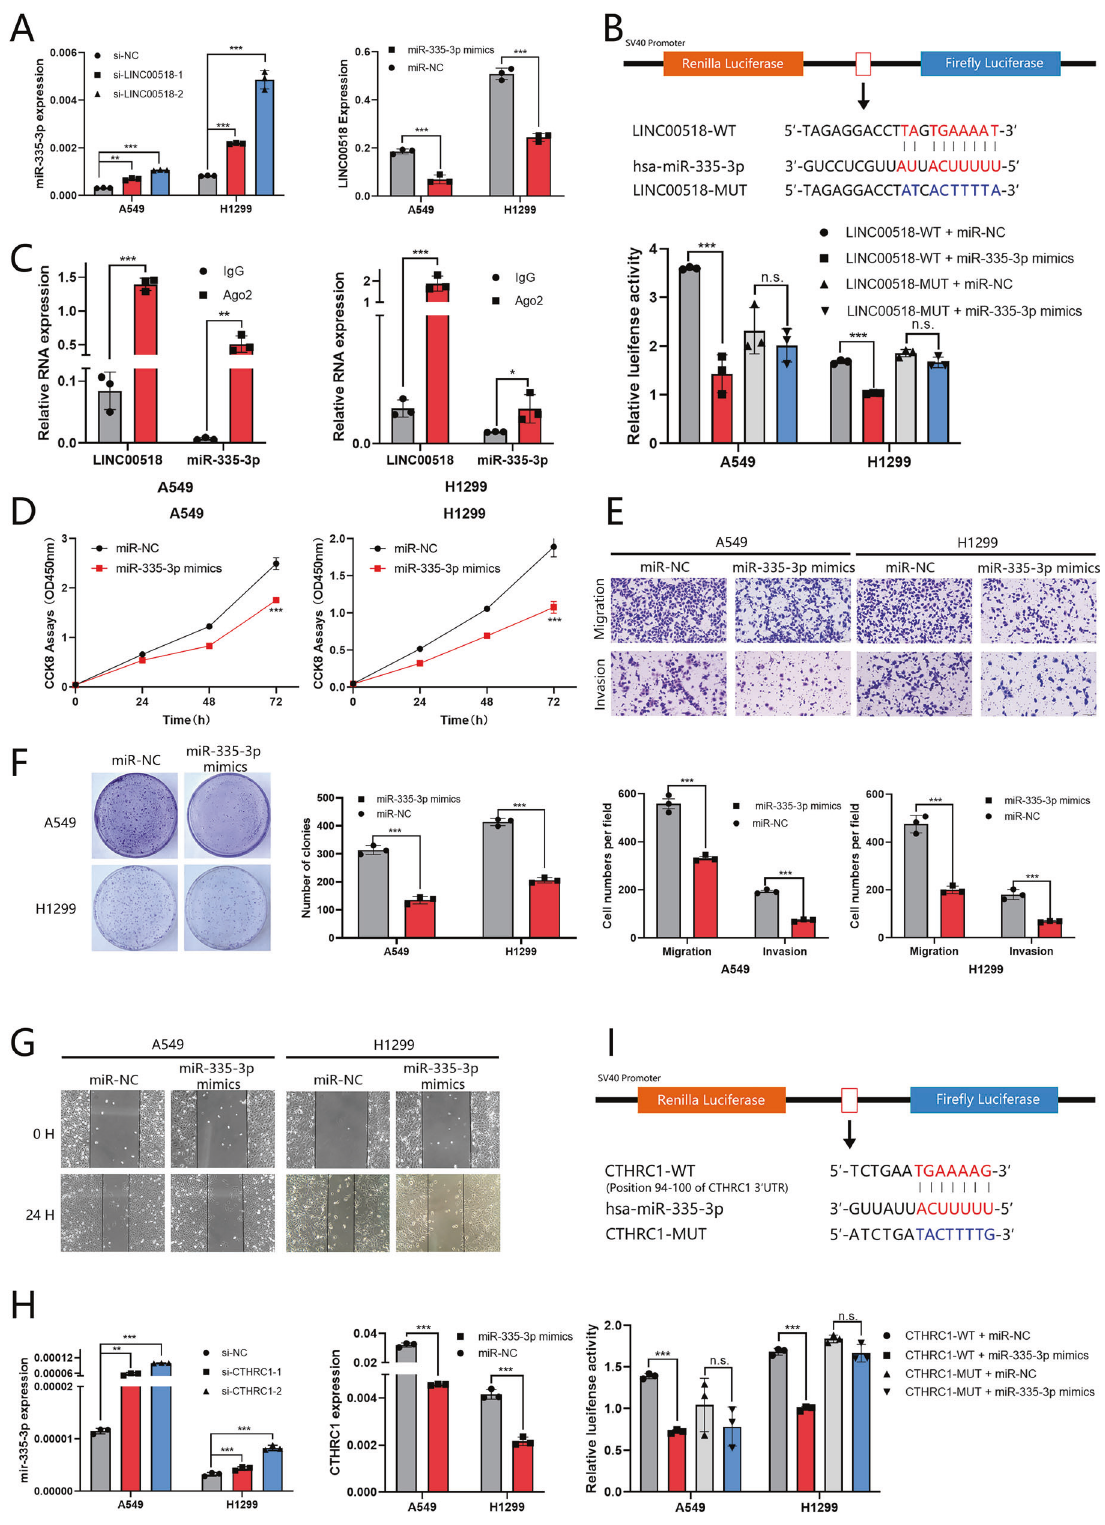
Fig. 3 LINC00518 directly targets miR-335-3p, promoting CTHRC1 expression and miR-335-3p suppresses LUAD cell proliferation and metastasis. A , H Detection of the expression of miR-335-3p in A549/H1299 cells transfected with LINC00518 siRNA, CTHRC1 siRNA, or NC and the expression of LINC00518 or CTHRC1 of cells transfectied with miR-335-3p mimics or NC. B , I The dual-luciferase assay showed that the relative dual-luciferase activity of the LINC00518-WT or CTHRC1-WT group was directly inhibited by miR-335-3p mimics. C The direct interaction between LINC00518 and miR-335-3p was veri fi ed by RIP assay. D , F Cell proliferation and colony formation of A549/H1299 cells was inhibited by miR-335-3p mimics. E , G Transwell assay and Wound-healing assay showing that miR-335-3p mimics signi fi cantly inhibited the ability of cell metastasis in A549/H1299 cells. All results indicate SD. (* P < 0.05, ** P < 0.01, *** P < 0.001).